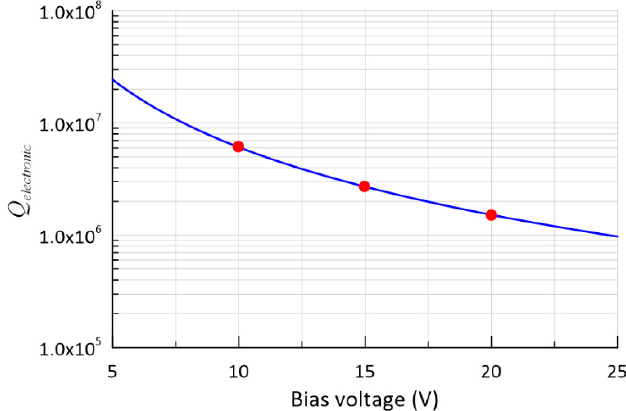
Figure 9. Relationship between Q and the bias voltage.